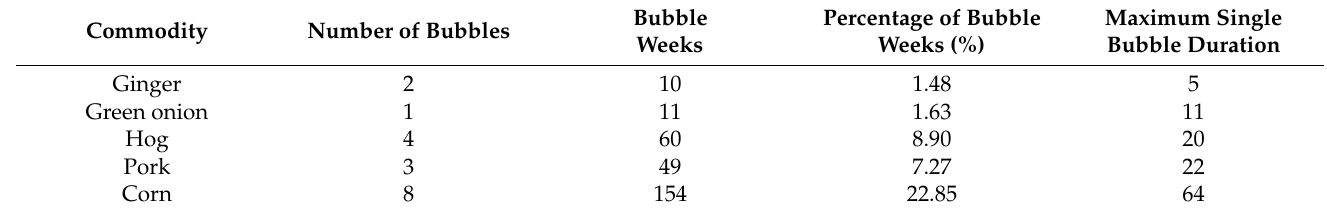
Table 3. The quantity and duration weeks of agricultural commodity price bubbles.